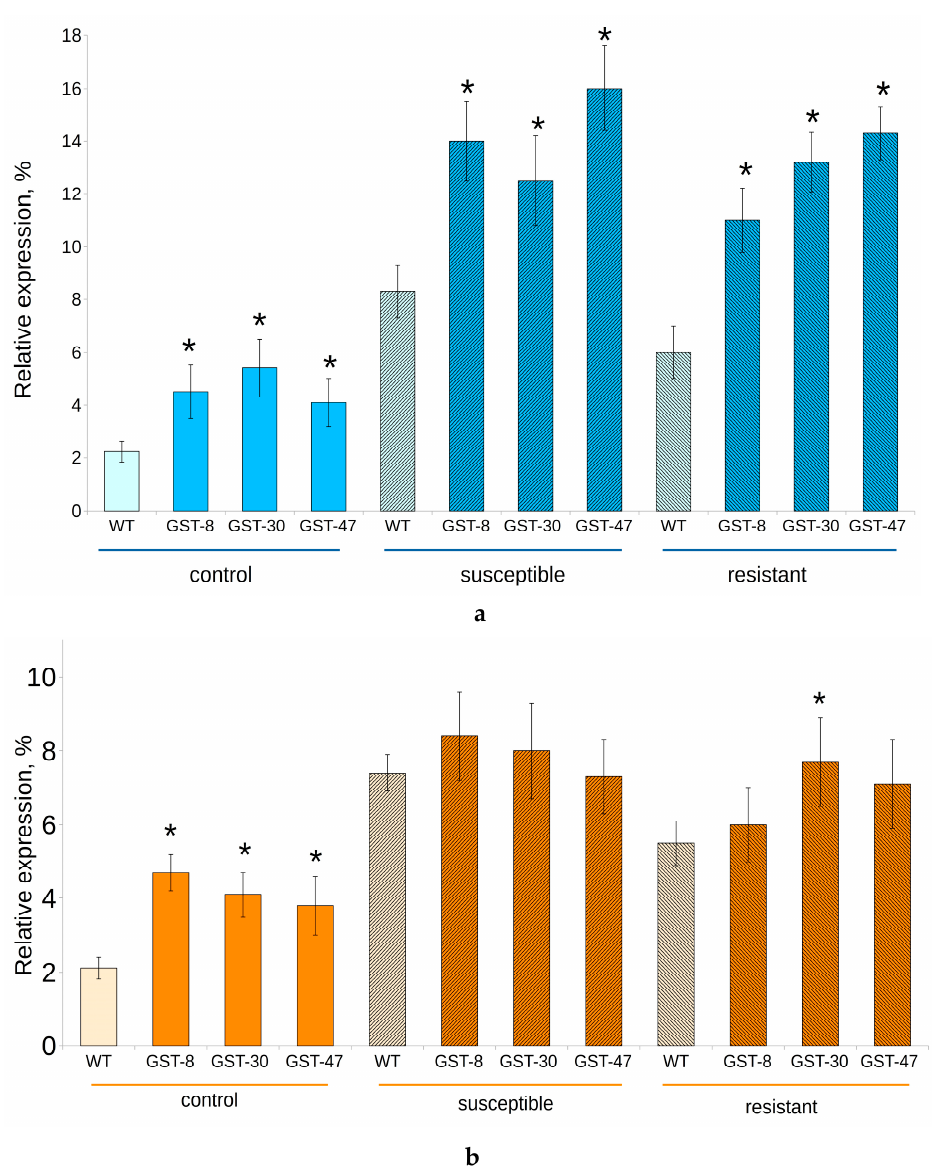
Figure 4. Relative expression level of GSTF11 gene in transgenic (GST, lines 8, 30 and 47) and wild type (WT) B. napus